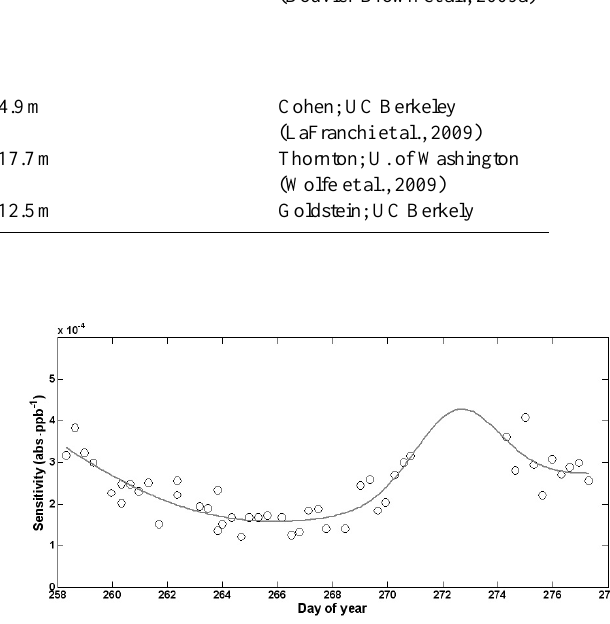
Fig. 3. Observed HCHO sensitivity variation (black circles) and the derived time-dependent sensitivity function using Gaussian fitting curves (gray line) throughout the measurement period. Y-axis is the integrated absorbance of HCHO per unit